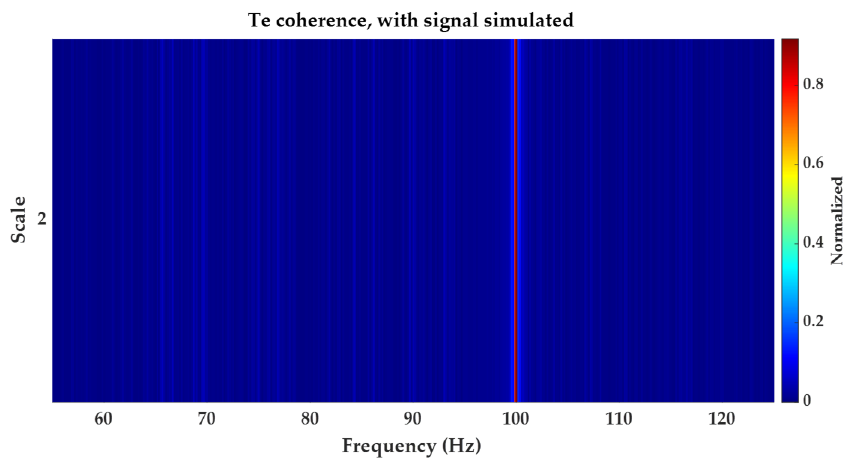
Figure 7. 𝒯 (cid:3032) coherence in Scale 2 , with two synthetic signals: 𝑆 (cid:2869) = 𝑠𝑖𝑛(2𝜋10𝑡) + 𝑠𝑖𝑛(2𝜋100𝑡) and Figure 7. T e coherence in Scale 2, with two synthetic signals: S 1 = sin ( 2 π 10 t ) + sin ( 2 π 100 t ) and 𝑆 (cid:2869) = 𝑠𝑖𝑛(2𝜋50𝑡) + 𝑠𝑖𝑛(2𝜋100𝑡) . Absolute error 1 ∗ 10 (cid:2879)(cid:2871) . S 1 = sin ( 2 π 50 t ) + sin ( 2 π 100 t ) . Absolute error 1 ∗ 10 − 3 .